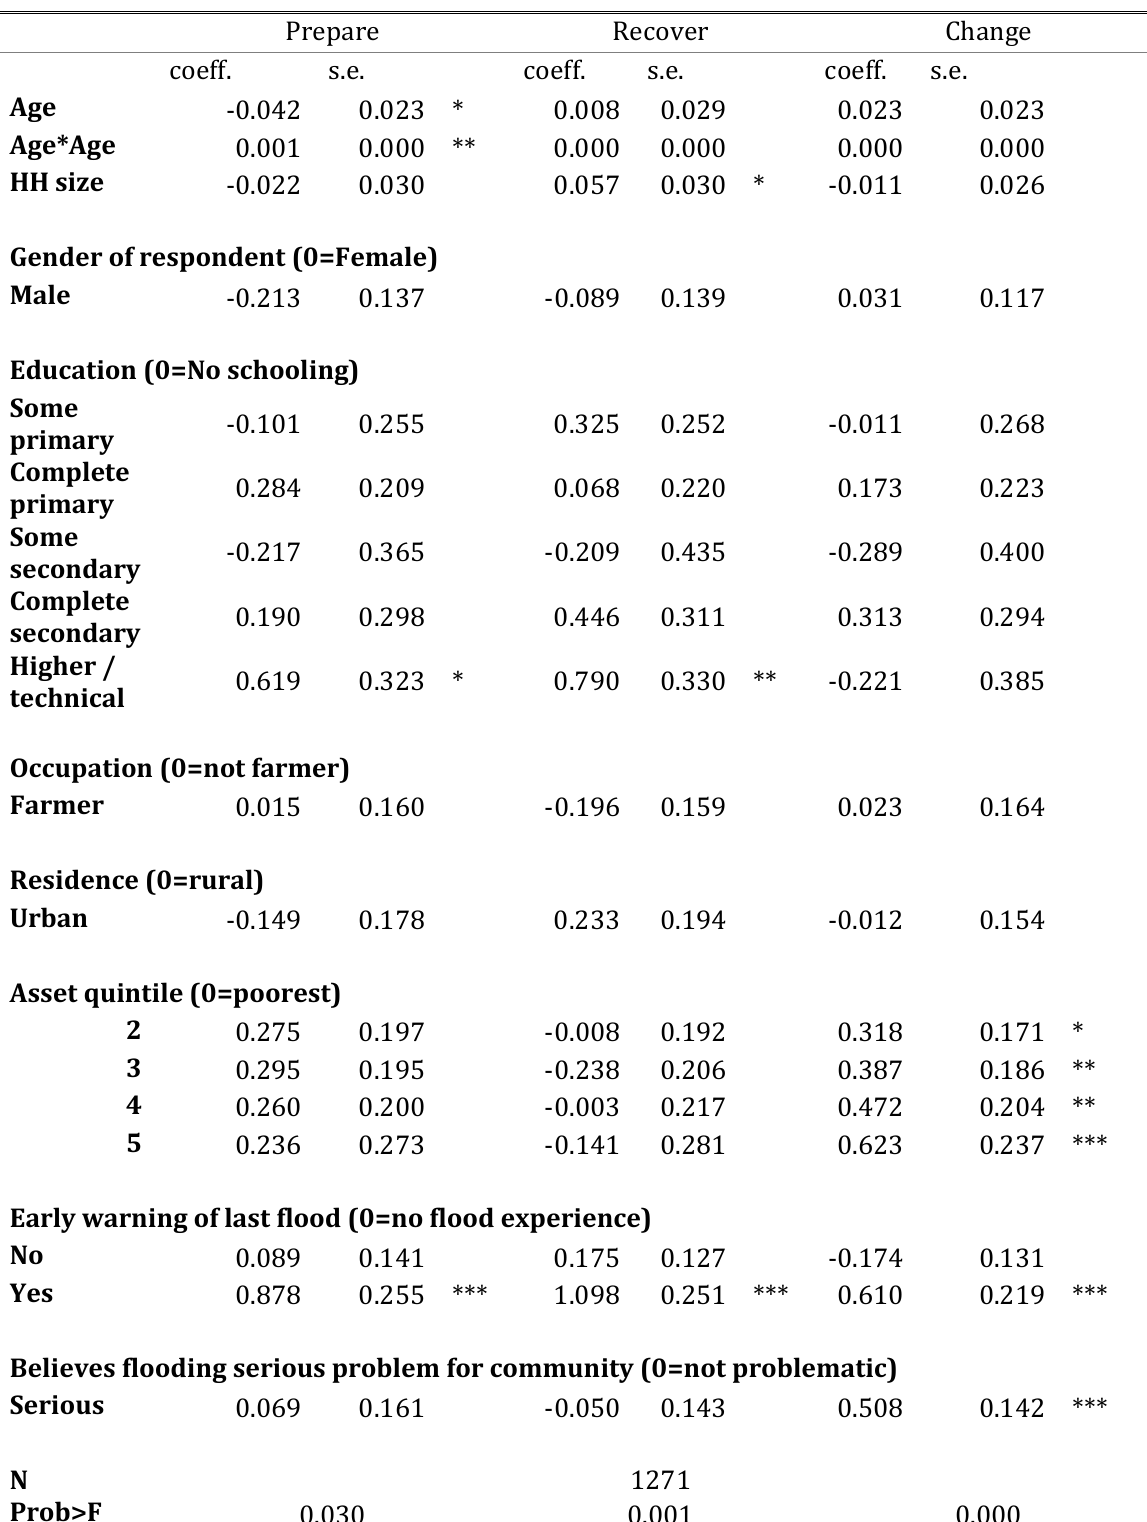
Table A1.7. Seemingly unrelated ordinal logit regressions on resilience-related capacities . Prepare Recover Change